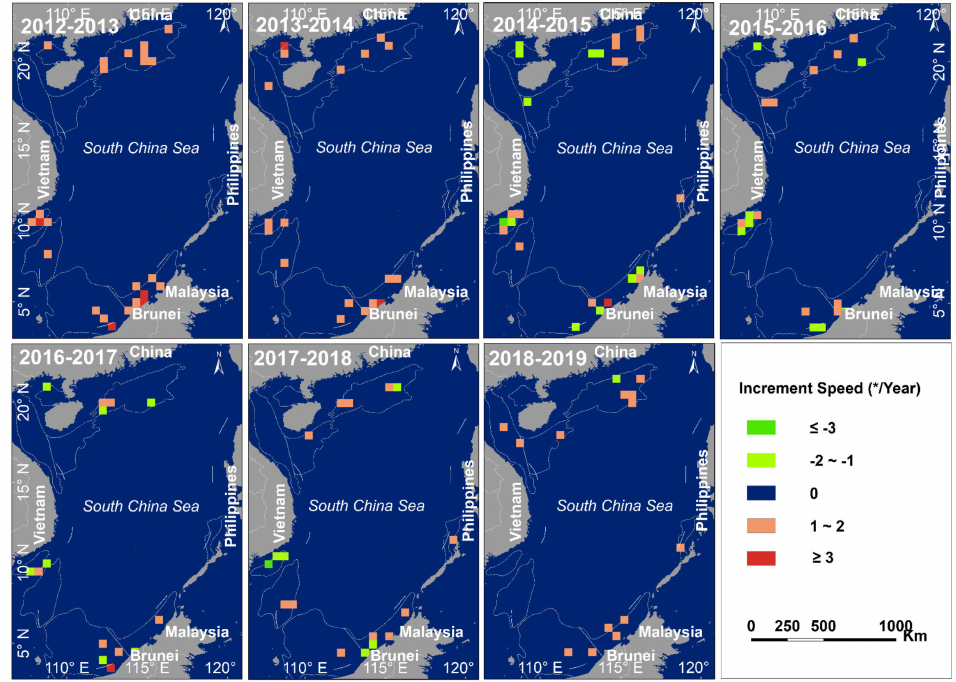
Figure 11. Spatial differentiation in the increment speed of offshore HE targets in each basin from 2012 to